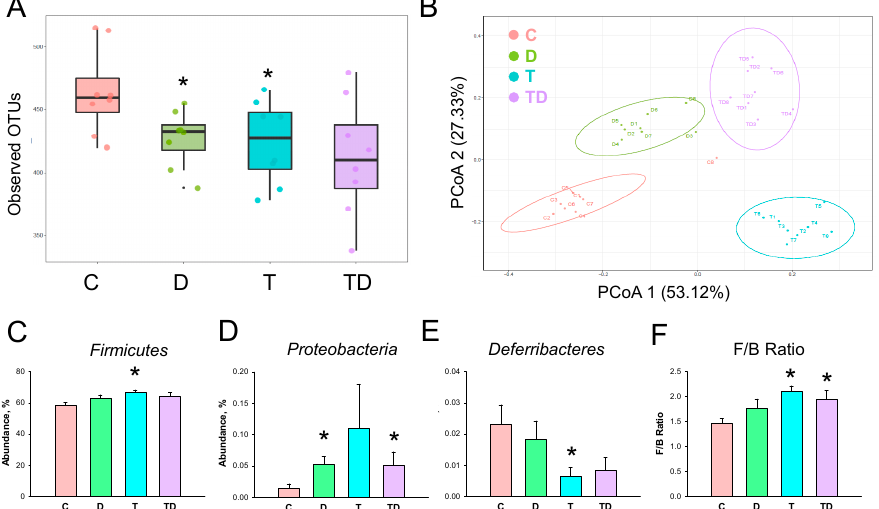
Figure 4. Effect of 3,3-Dimethyl-1-butanol (D) and 2,3,7,8-tetrachlorodibenzo-p-dioxin (T) on the gut microbiome in offspring. ( A ) α -diversity measured by the observed operational taxonomic units (OTUs). ( B ) β -diversity using the Principal Coordinate Analysis (PCoA). Relative abundance of the phylum ( C ) Firmicutes , ( D ) Proteobacteria , and ( E ) Deferribacteres . ( F ) The Firmicutes to Bacteroidetes (F/B) ratio. N = 8 per group; * p < 0.05 vs. C.